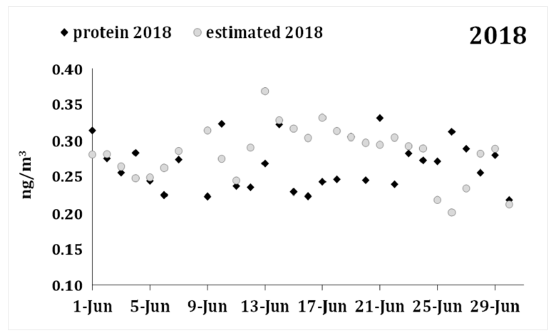
Figure 7. Graph of the detected airborne protein concentrations in 2018 and the forecast values obtained by the developed regression model (Table S5). Table 6 . T-test for dependent samples between real and forecast values of airborne protein concen- trations in 2018. Marked differences are significant at p < 0.05. Variable